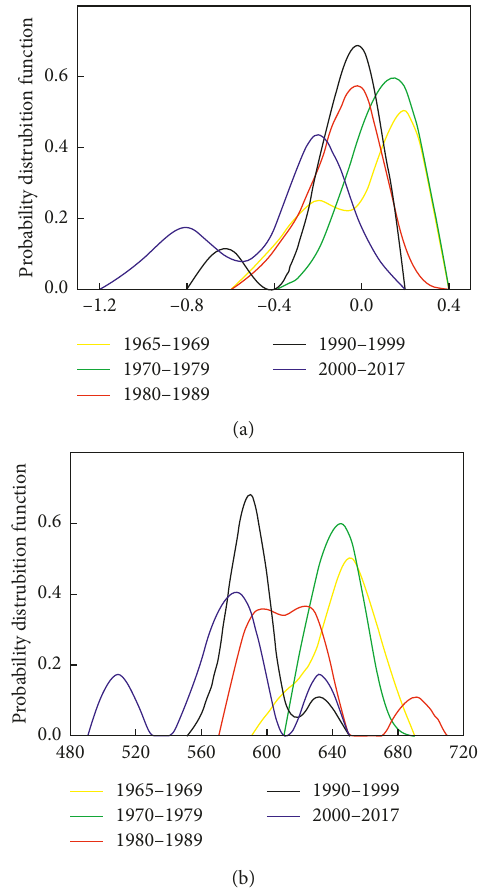
Figure 4: Probability distribution functions of precipitation indices in Northeast China during 1965–2017. (a) AI. (b)